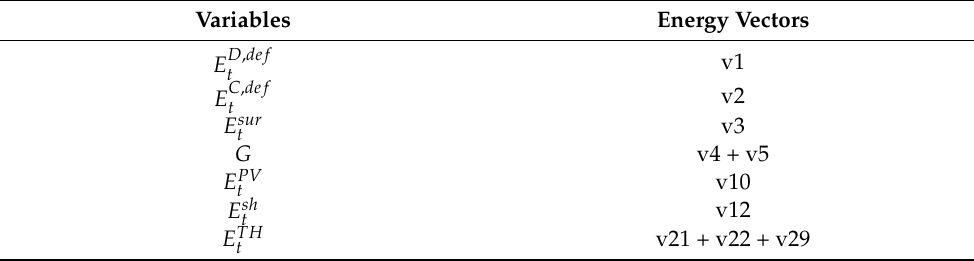
Table 1. Relationships between EC variables and energy